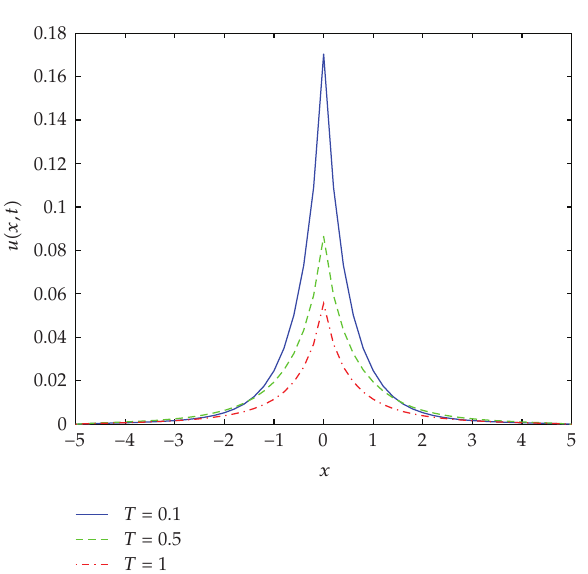
Figure 4: Numerical solutions for Example 5.2 with α (cid:7) 0 . 5 and μ (cid:7) 1 . 5 at di ff erent times T (cid:7) 0 . 1 , 0 . 5 , 1 . 0.